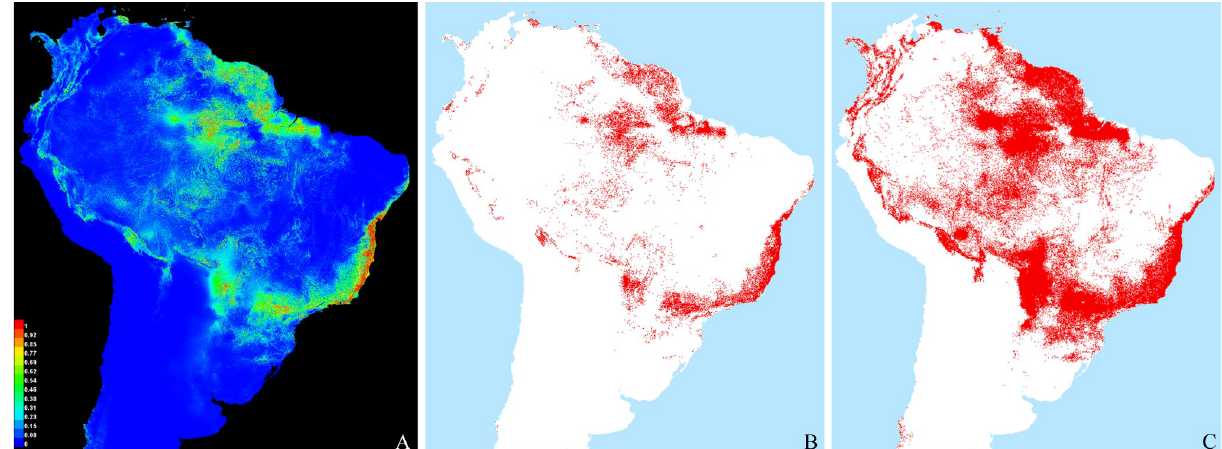
Fig 22. Potential distribution for Cryptoxenodon metamorphus sp. nov. (A) MaxEnt model with scale of probabilities. (B) Binary map with a limiar of 0.4043 (Maximum Training Sensitivity Plus Specific). (C) Binary map with a limiar of 0.1168 (Minimum Training Presence).